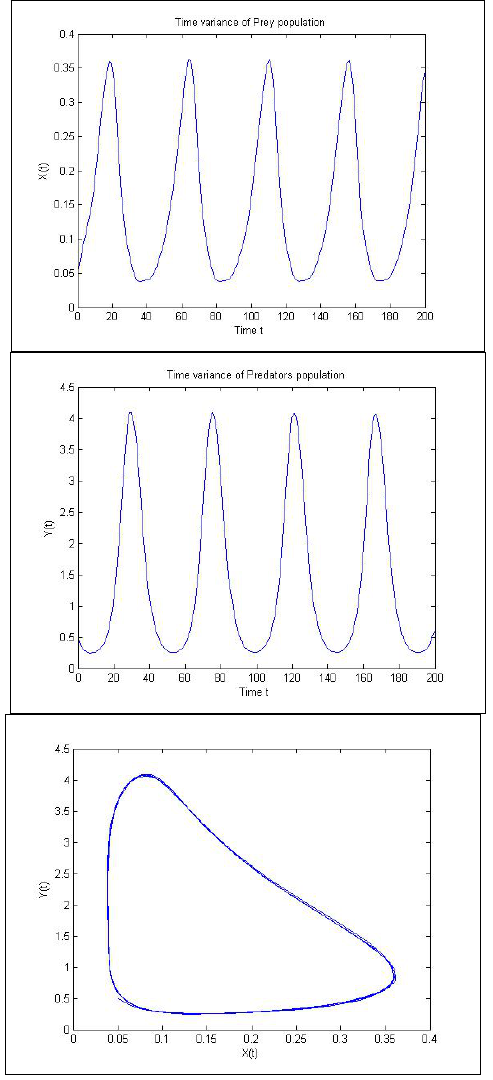
Fig. 12. The positive equilibrium is unstable for τ 1 = 7 and τ 2 = 3 . 1 .The system exhibits an unstable periodic